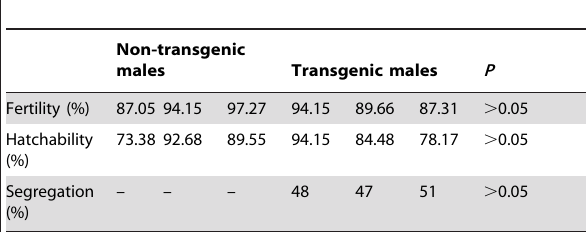
Table 2. Fertilization, hatching rates and transgene